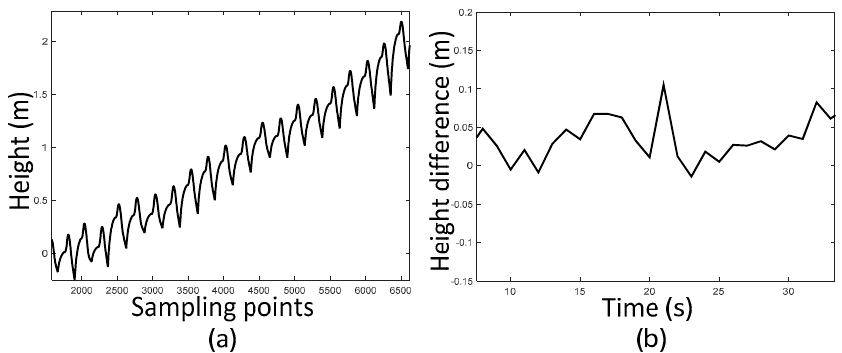
Figure 18. The accumulative error of height estimation and the height difference every one second; ( a ) is the accumulative error. It reaches 2 m after 5000 sampling points (25 s); ( b ) is the height difference every one second. Although the height error accumulated, the height difference stay steady and it is possible to use this information to aid barometer to estimate the height more precisely.